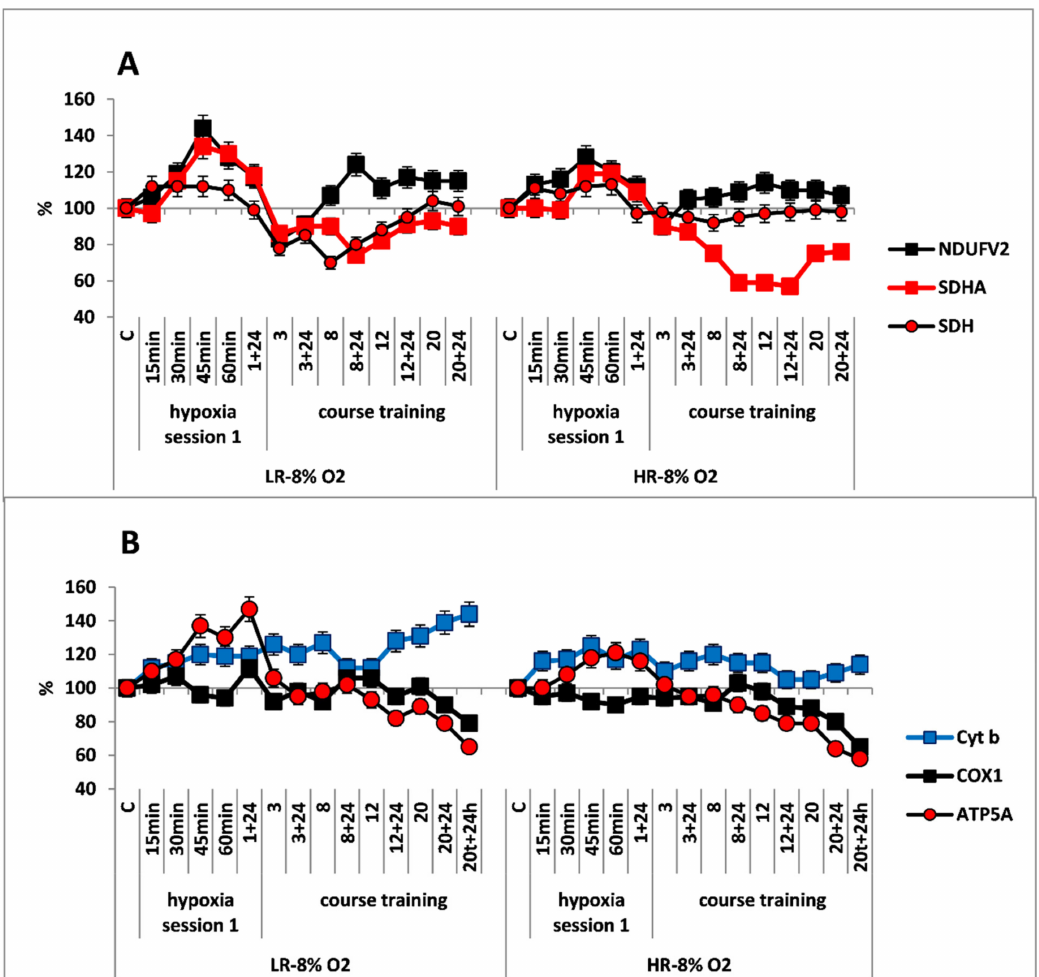
Figure 6. Effect of long-term hypobaric hypoxia (HBH, 8% O 2 ; 20 daily one-hour sessions) on the dynamics of the CC content of mitochondrial enzymes in low-resistance (LR) and high-resistance (HR) rats. ( A ) NDUFV2 (MC I), SDHA (MC II) catalytic subunits (% of control) and SDH activity. ( B ) Cyt b (MC III), COX1 (MC IV) and ATP5A (MC V) catalytic subunits (% of control). For other designations, see legends to Figure